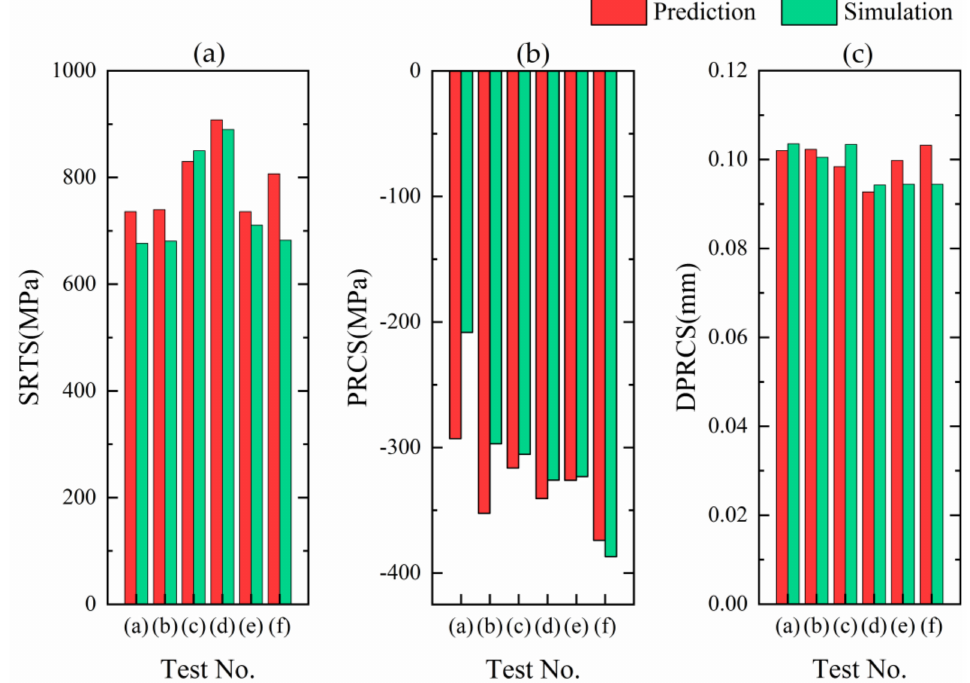
Figure 10. The indicators of predicted and simulated residual stress distribution. ( a ) The comparisons of predicted and simulated SRTS; ( b ) The comparisons of predicted and simulated PRCS; ( c ) The comparisons of predicted and simulated